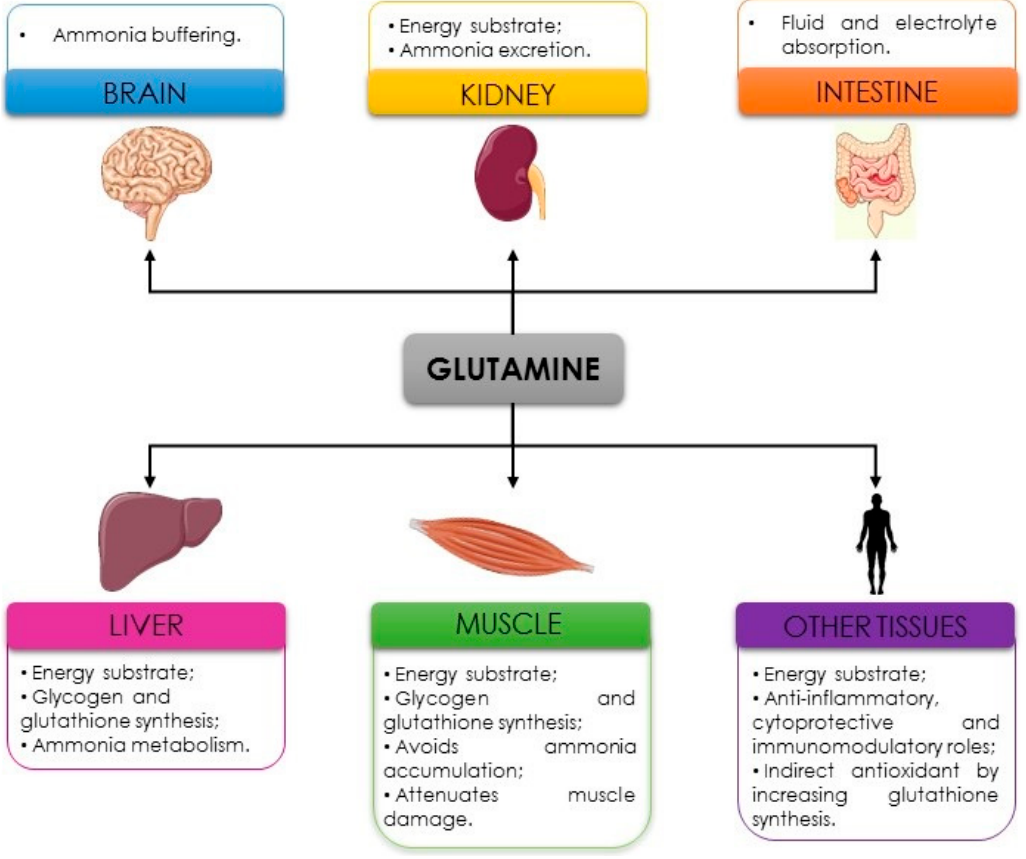
Figure 2. Anti-fatigue properties of glutamine.